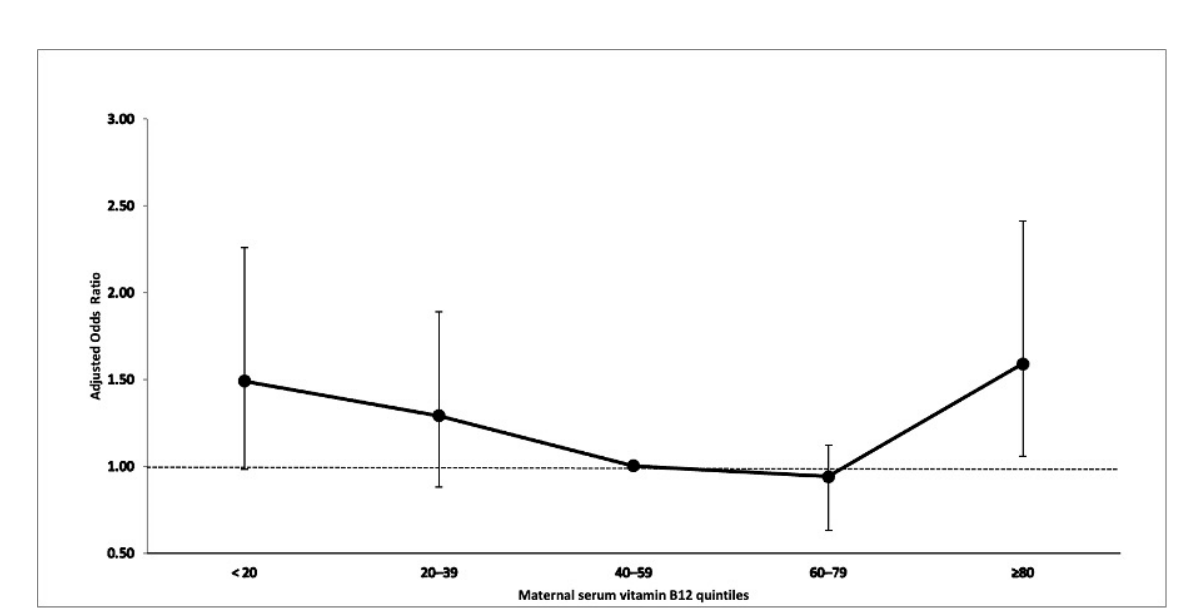
Figure 1 . Association between maternal serum vitamin B12 and offspring childhood autism . Figure 1. Association between maternal serum vitamin B12 and offspring childhood